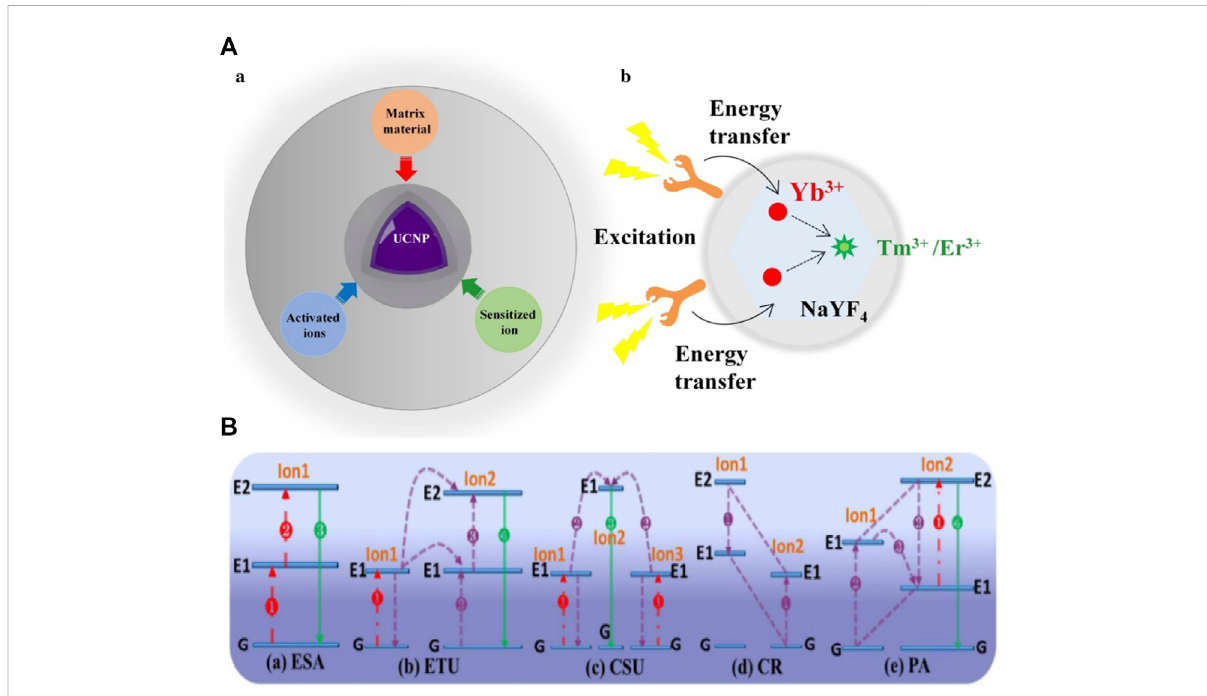
FIGURE 2 (A) (a) The basic composition of UCNPs: matrix material, activated ions, and sensitized ion; (b) schematic illustration of the mechanism of organicdye-sensitizedUCNPs(Liangetal.,2020a). (B) Excited-state absorption (ESA), energytransferupconversion (ETU),cooperativesensitization upconversion (CSU), cross relaxation (CR), and photon avalanche (PA). The red, violet, and green lines, respectively, represent photon excitation, energy transfer, and emission processes (Chen et al.,